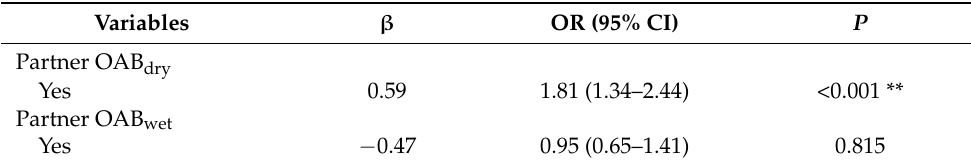
Table 2. Associated factors for OAB dry in middle-aged women. Variables β OR (95% CI) P